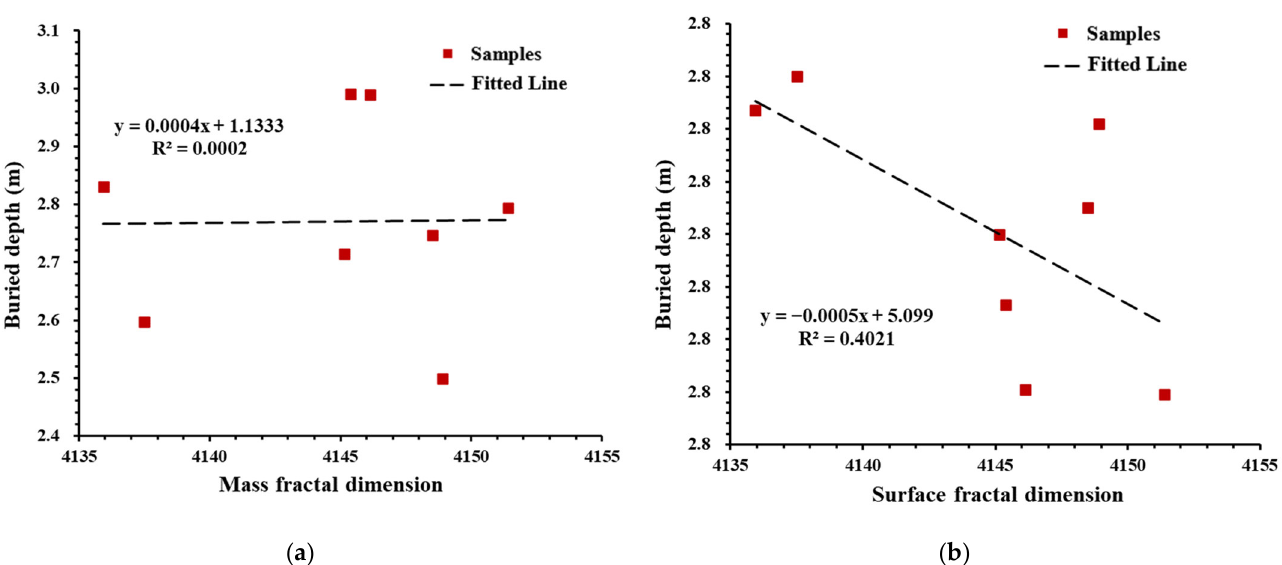
Figure 13. ( a ) Relationship between the mass fractal dimension and burial depth of the deep shale samples. ( b ) Relationship between the surface fractal dimension and burial depth of the deep shale